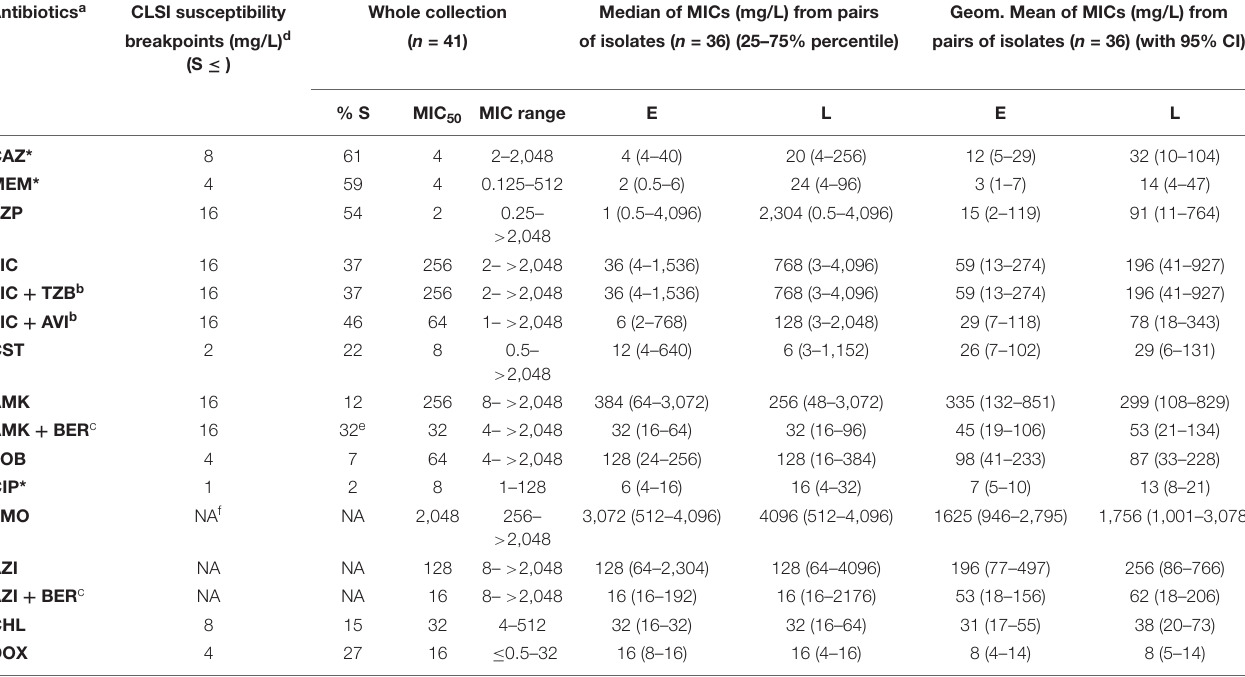
TABLE 2 | Antimicrobial susceptibility to different antibiotics among the 41 clinical isolates [including 18 pairs of successive isolates with 1–11 year’s interval between the early (E) and late (L) sample] of Achromobacter spp.